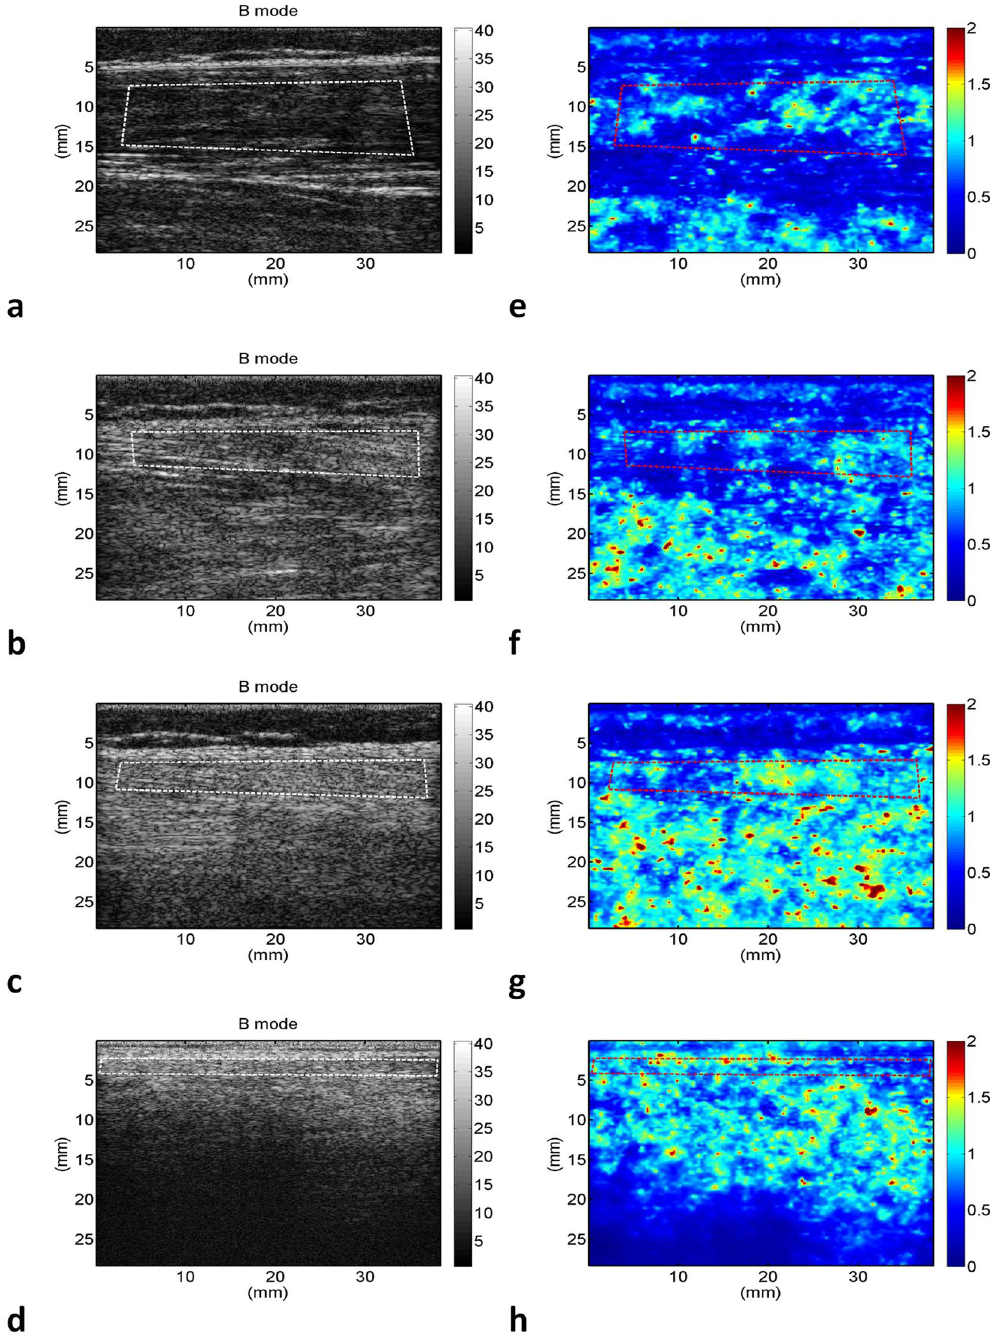
Figure 2. Grayscale B-mode images of the tibialis anterior muscle of the ( a ) controls; ( b ) stage 1 DMD patients; ( c ) stage 2 DMD patients; and ( d ) stage 3 DMD patients. ( e – h ) Corresponding WMC Nakagami images showing an increase in brightness of the WMC Nakagami image with an increase in the DMD stage, representing an increase in the Nakagami